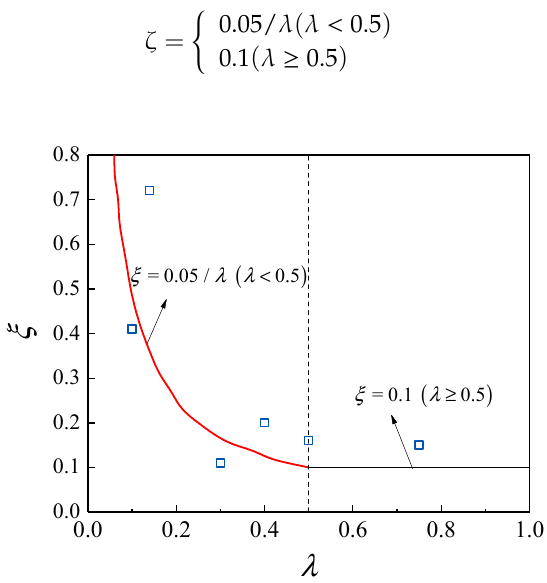
Figure 16. Axis pressure influence coefficient change curve.